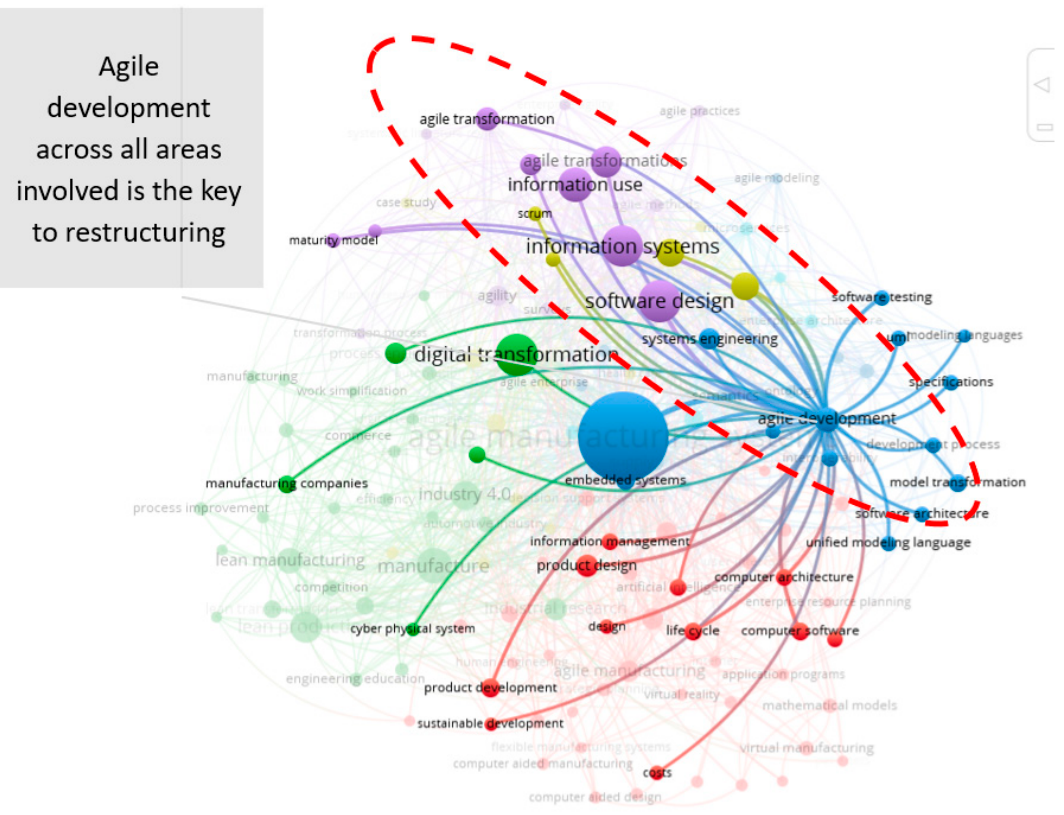
Figure 10. Focus keywords in most articles are agility in development and software design.